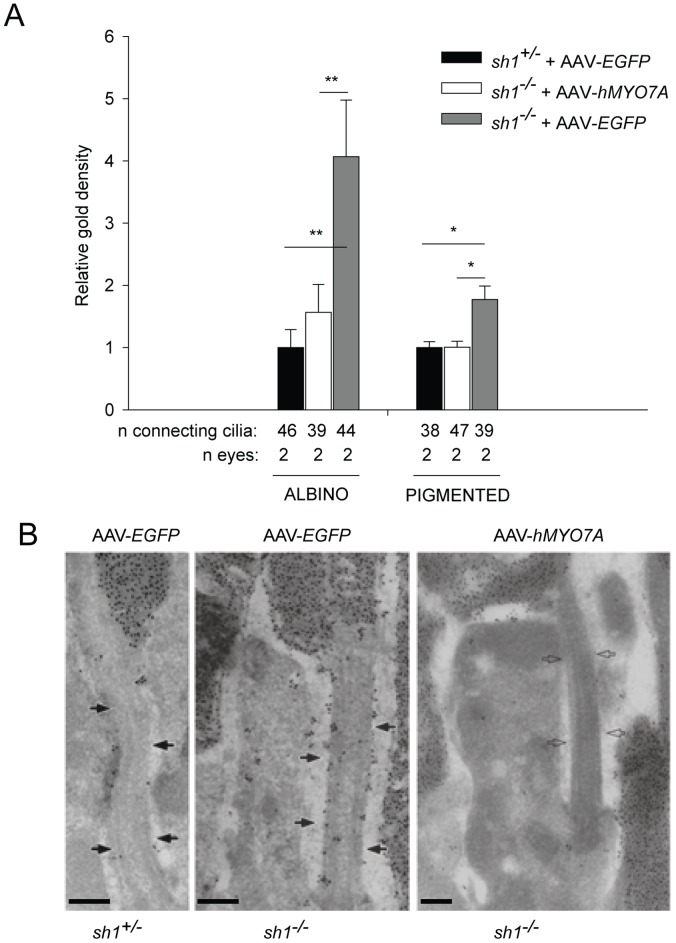
Subretinal delivery of AAV encoding human Myo7a rescues Rhodopsin accumulation in sh1−/− photoreceptor connecting cilium.
A. Quantification of the gold particle density (corresponding to Rhodopsin molecule density) in the connecting cilium of sh1 mice. The quantification is depicted as relative gold density (average gold particle density in sh1/average gold particle density in sh1+/− mice). Albino sh1 mice were analyzed at 4 months following the injections; pigmented sh1 mice were analyzed at 4 or 7 months following the injections. Data are presented as mean±SEM. *p value<0.05; **p value<0.001. More details on the statistical analysis including specific statistical values can be found in the Statistical analysis paragraph of the Materials and Methods section. B. Representative pictures of photoreceptor connecting cilium containing Rhodopsin immuno-labelled with anti-Rhodopsin antibody in pigmented sh1 mice at 4 months following the treatment. The black arrows point at the connecting cilium of sh1+/− and sh1−/− mice treated with AAV-EGFP, while white arrows point at the connecting cilium of sh1−/− mice treated with AAV-hMYO7A. The scale bar is 200 nm. AAV-hMYO7A: AAV2/5-CMV-hMYO7A; AAV-EGFP: AAV2/5-CMV-EGFP.